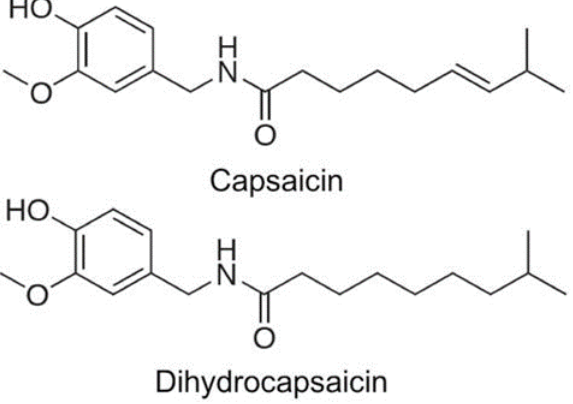
Figure 1. The chemical structures of capsaicin and dihydrocapsaicin. Reproduced from Guzmán